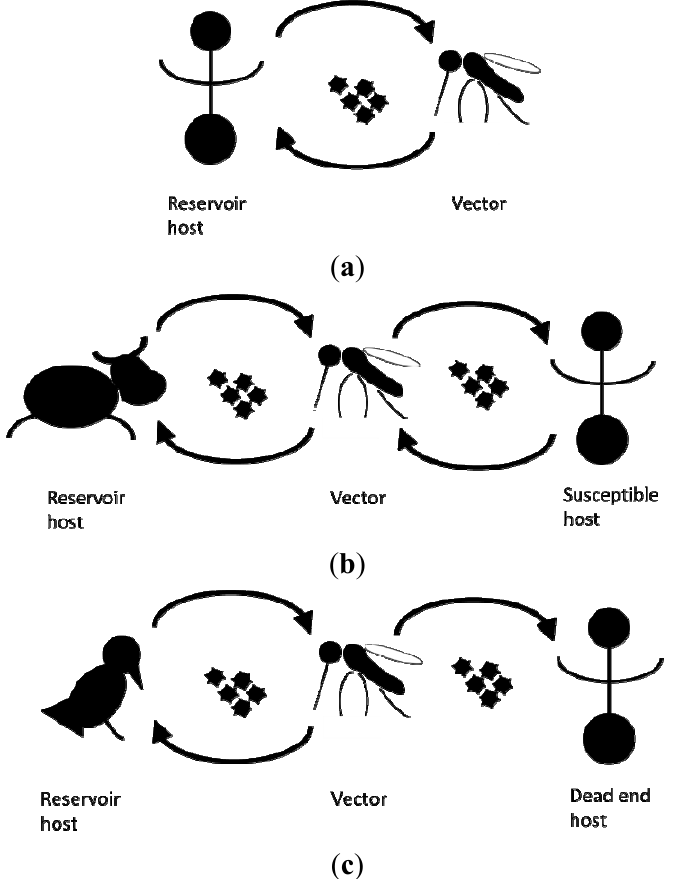
Figure 1. Schematic representation of the transmission cycles of ( a ) dengue virus, ( b ) Rift valley fever virus, ( c ) West Nile fever